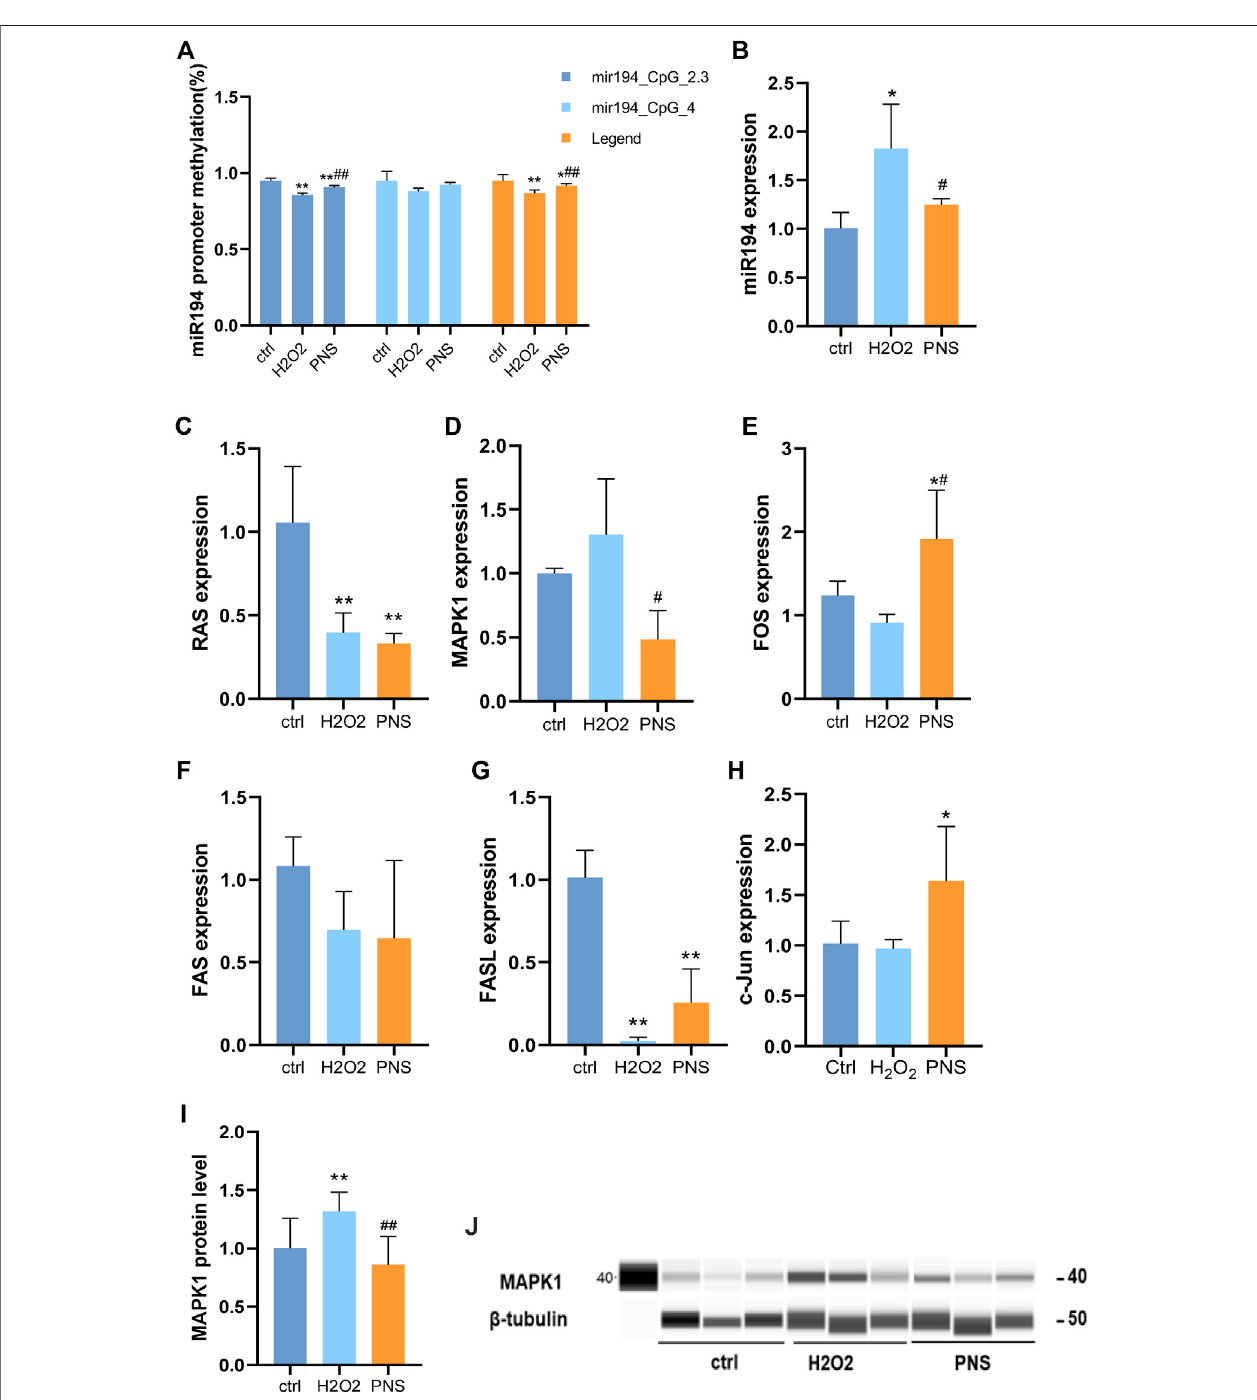
FIGURE5| PredictionofPNS targetsbypharmacologicalanalysis. (A) Top20potentialtargetsofPNS.Therelationshipofthetop20bestmatchinggenesofPNS was exhibited by Cytoscape. Yellow squares indicate the main ingredients of PNS. The circles indicate the potential targets. The nodes with a higher degree appear redder in color. The nodes with a higher fi t value have thicker edges. (B) Common targets of the main ingredients of PNS. (C) Common targets of PNS potential targets and CAD-related genes.